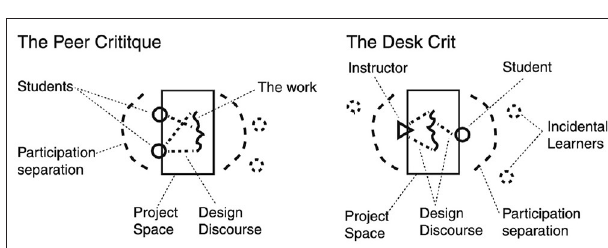
FIGURE 2 | An image from Hokanson (2012, p.78) showing to the left, a peer critique and to the right a desk crit with the instructor. It is relevant to note how the proximity to this event allows for incidental